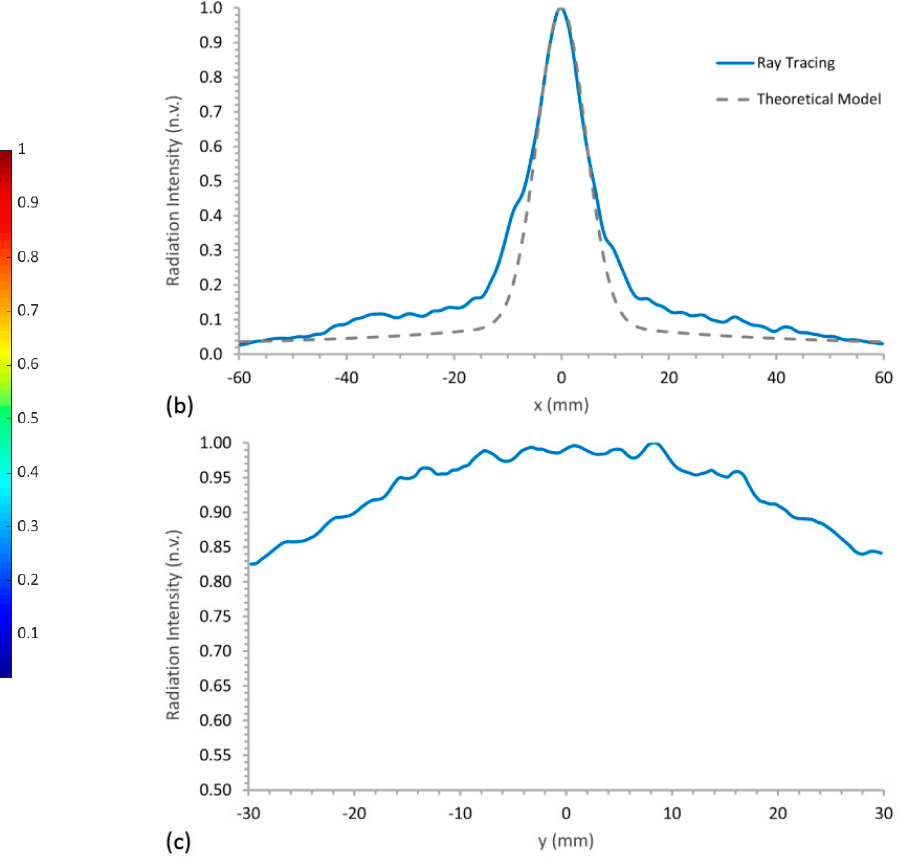
Figure 4. Ray-tracing simulation of the radiation intensity over the recrystallized pre-ribbon (normal- ized): ( a ) xy plane intensity map; ( b , c ) profiles along the x and y directions. ized): ( a ) xy plane intensity map; ( b , c ) profiles along the x and y